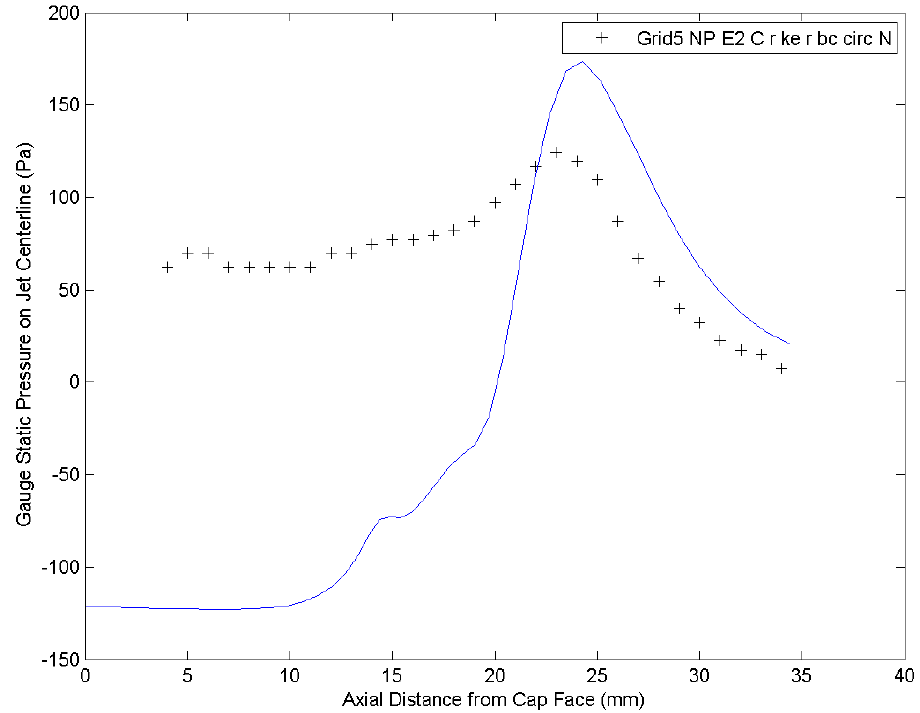
Figure 22. Experiment 2: The Near Field Centerline Static Pressure: Comparison of numerical (line) and experimental (crosses)